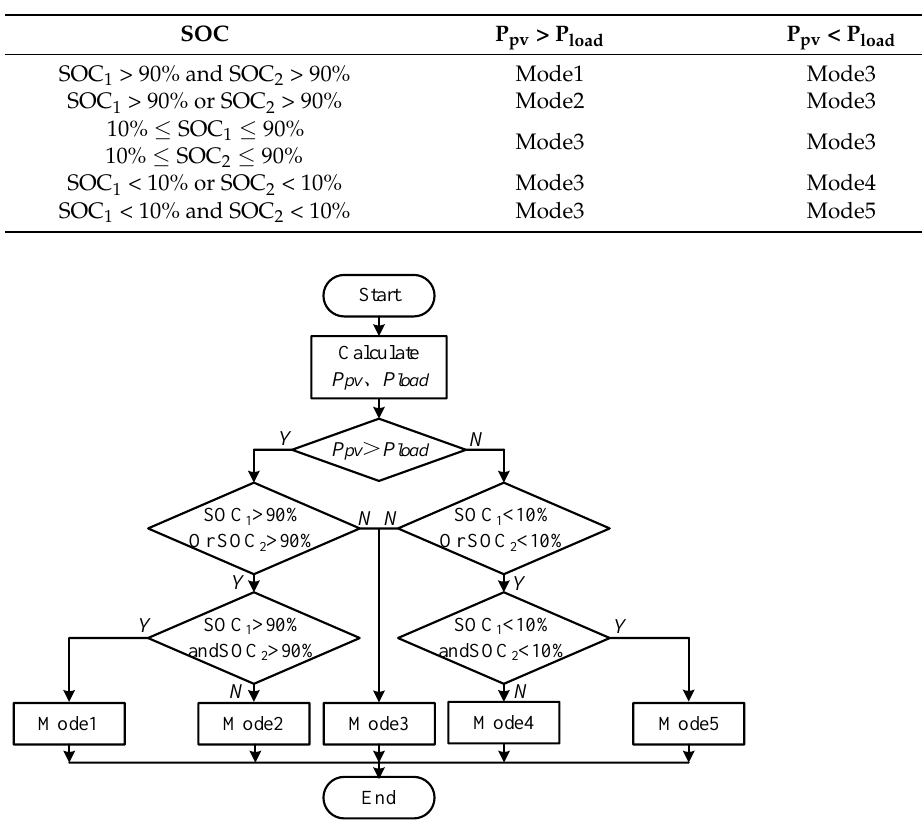
Table 4. Running condition and control mode.